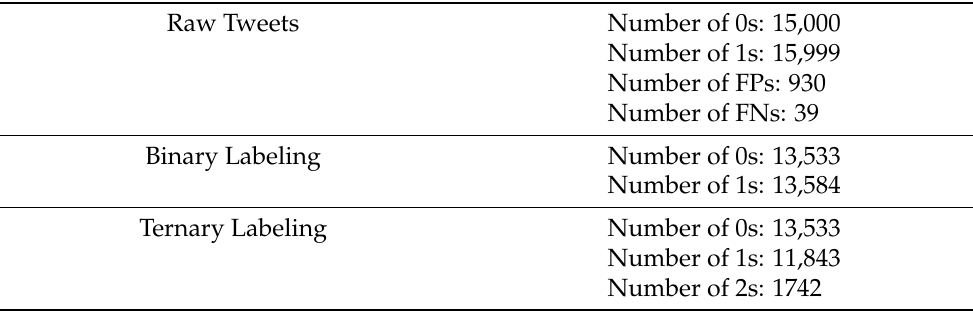
Table 4. Number of labels. Raw